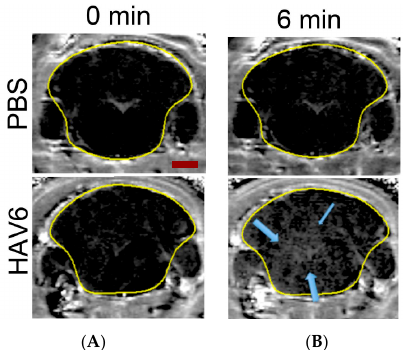
Figure 1. Representative MRI T1-weighted images of mouse brain taken at 0 min ( A ) and 6 min ( B ) following the injection of Gd-DTPA in control (PBS) and HAV6 (0.01mmol/kg) treated mice. Blue arrows indicate regions of Gd-DTPA enhancement following the injection of the peptide. Scale bar represent 2mm.